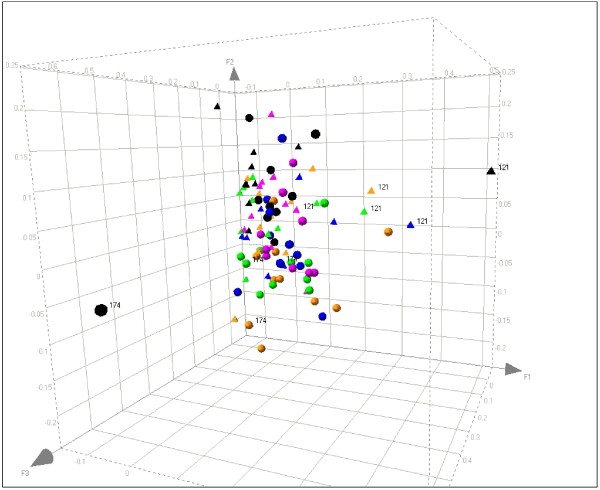
Correspondence analysis of microarray samples. Correspondence analysis was performed on gene intensity signals measured on a subset of 22 individuals. Circles represent females; triangles represent males. Time points are colored as follows: orange = Day 1; green = Day 14; blue = Day 28; black = Day 90; pink = Day 180. Outliers are numbered (Subjects 121 and 174). Subject 174 died prior to Day 180; therefore, that sample was not available for analysis. The three axes displayed explain 32% of the variance of the whole dataset. Each data point on the graph represents a projection of the expression profile (34,573 probe sets in this case; see materials and methods for filtering of the data set) of one subject at a single time point. The distance between subjects reflects the distance between their entire gene expression profiles.